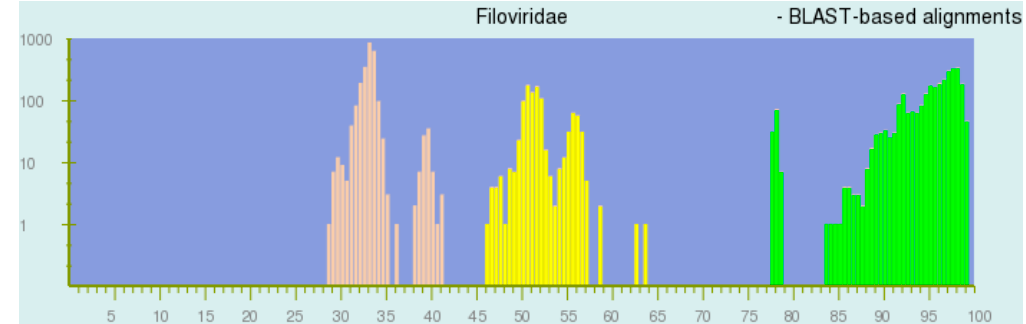
Figure 1. Screenshot of the US National Center for Biotechnology Information (NCBI) PAirwise Sequence Comparison (PASC) tool result after comparing 112 distinct near-complete, coding-complete or complete filovirus genome sequences. Brown bars represent genome pairs assigned to (three) different genera; yellow bars represent genome pairs assigned to (seven) separate species; and green bars represent genome pairs assigned to the same species. BLAST: Basic Local Alignment Search Tool.